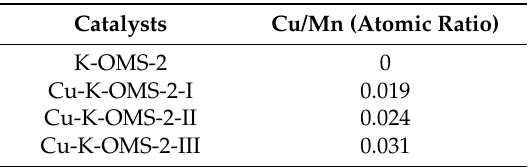
Table 1. Atomic ratios of Cu to Mn in the catalysts.